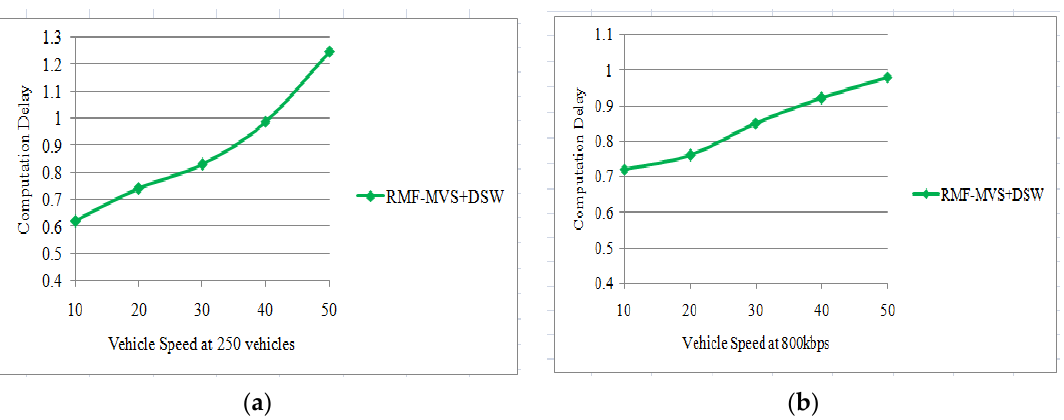
Figure 12. Computation Delay against Varied Number of ( a ) Mobility (Speed) at Fixed Number of Vehicles (250) and ( b ) Data Rates (800 kbps).